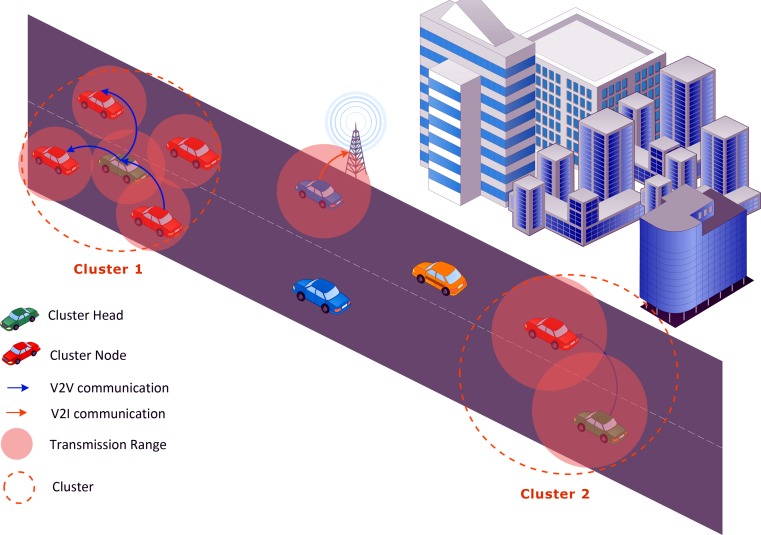
Clustering in VANET.